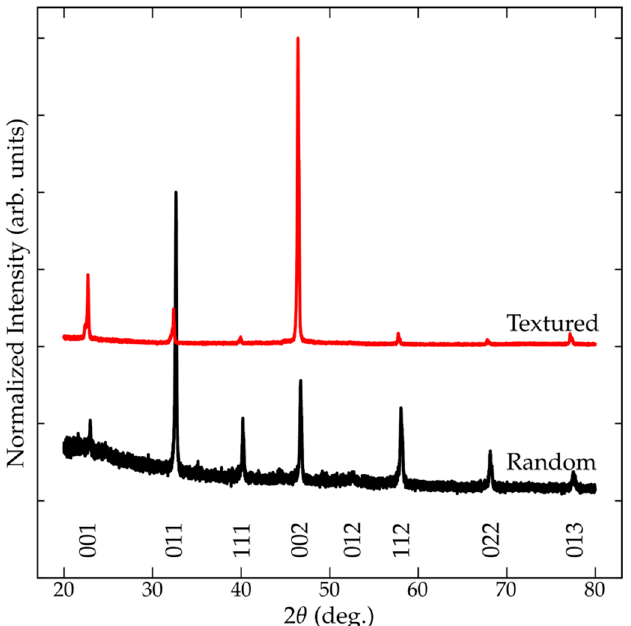
Figure 1. Comparison of the θ -2 θ diffraction patterns for a randomly oriented and textured BNT- BT-KNN